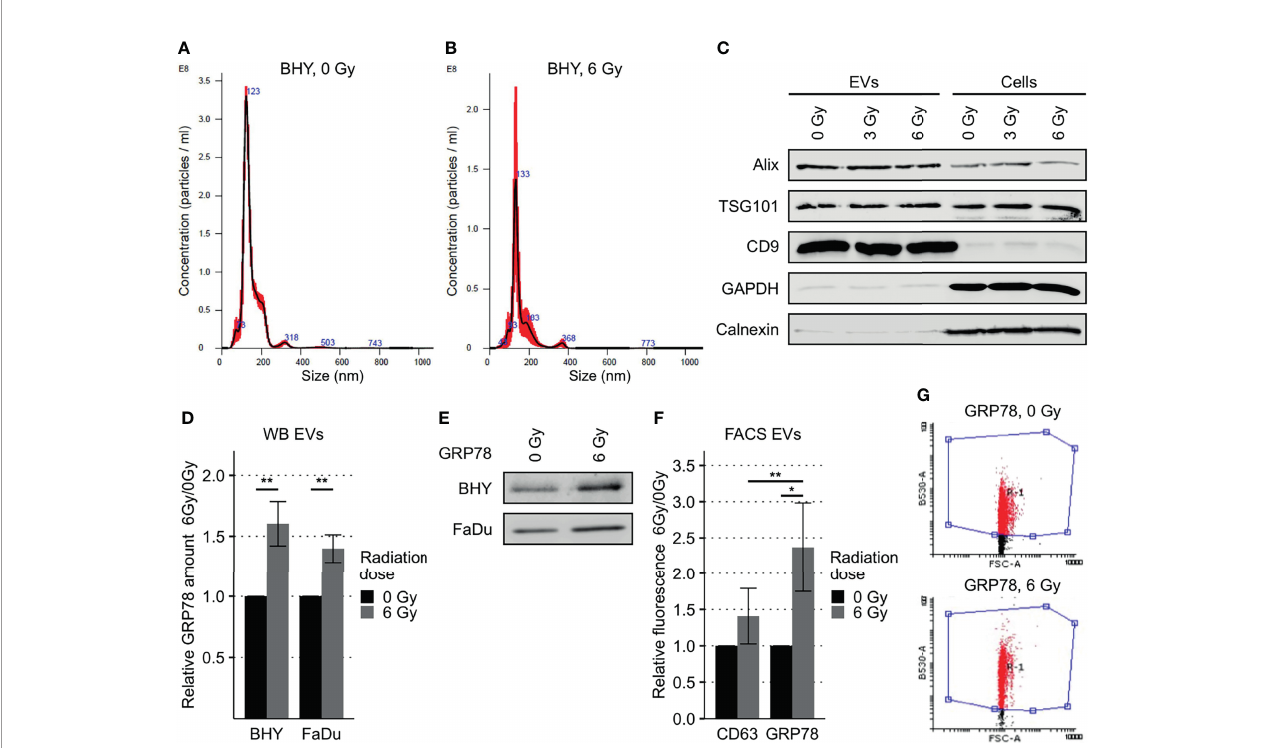
FIGURE 6 | Increased GRP78 expression in HNSCC EVs. (A, B) Nanoparticle tracking analysis of EVs collected via serial ultracentrifugation from cell culture supernatant of irradiated (6 Gy) and non-irradiated (0Gy) BHY cells. (C) Western Blot of BHY EVs with positive (Alix, TSG101, CD9) and negative (GAPDH, Calnexin) EV markers. (D, E) Western Blot analysis with representative blot (E) shows increased amounts of GRP78 in EVs derived from irradiated cells (6Gy-EVs) in comparison to EVs derived from non-irradiated HNSCC cells (0Gy-EVs). GRP78 expression was normalized to Ponceau S staining and 0 Gy served as baseline (n = 4, t-test, **p < 0.01). (F, G) Flow cytometry analysis of GRP78 surface expression on BHY EVs show increased GRP78 on 6Gy-EVs compared to 0Gy-EVs. CD63 was used as control surface antigen showing no signi fi cant change in radiation induced surface expression (n = 4, t-test, *p adj. < 0.05). (G) Example dot blots of bead-coupled EVs in fl ow cytometric analysis.